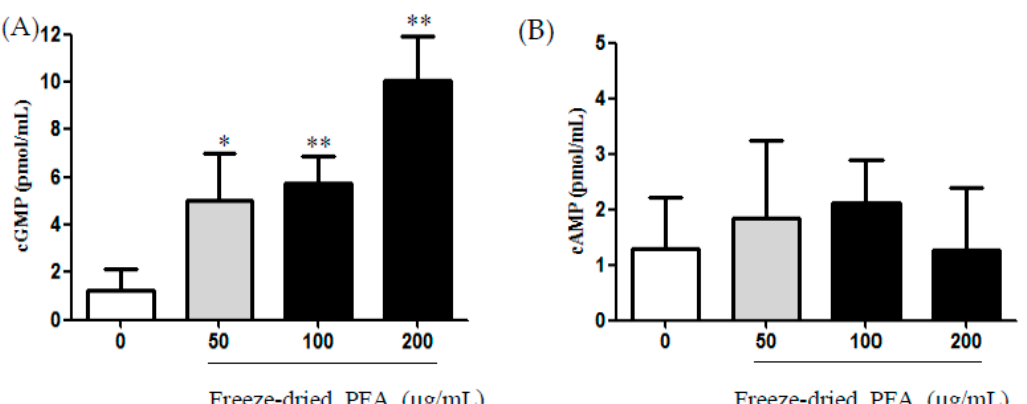
Figure 4. Effect of freeze-dried Perilla frutescens var. acuta (PFA) on cGMP and cAMP contents in rat ciliary smooth muscle cells. ( A ) Intracellular concentration of cGMP after 15 min of freeze-dried PFA treatment at 50 µg/mL, 100 µg/mL, and 200 µg/mL. ( B ) Intracellular concentration of cAMP after 15 min of freeze-dried PFA treatment at 50 µg/mL, 100 µg/mL, and 200 µg/mL. The data are represented as mean ± SD. * p < 0.05 and ** p < 0.01.